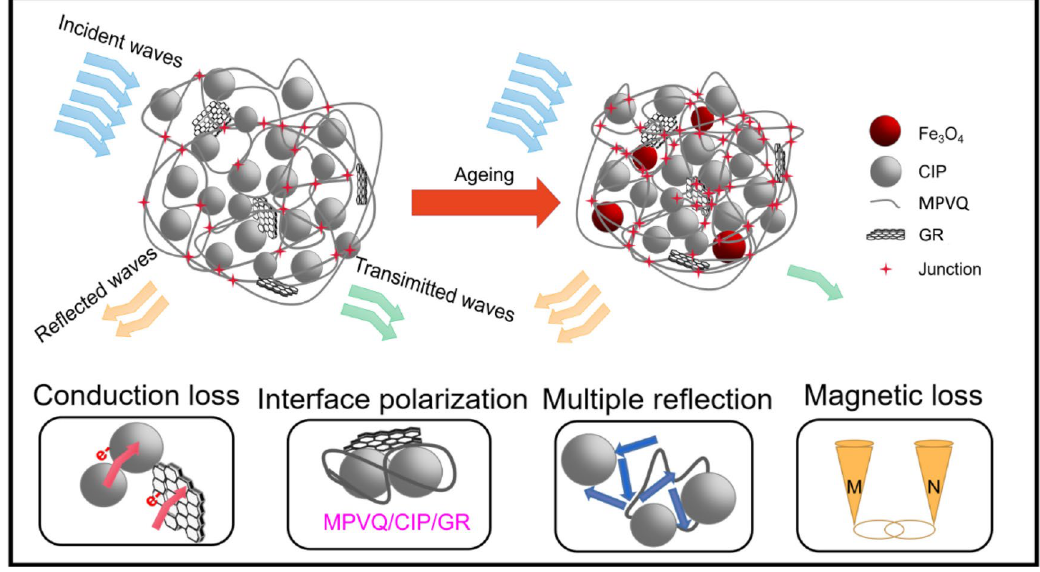
Figure 10. Schematic diagram of the influence mechanism of thermal-ageing on the electromagnetic wave- absorbing property of the